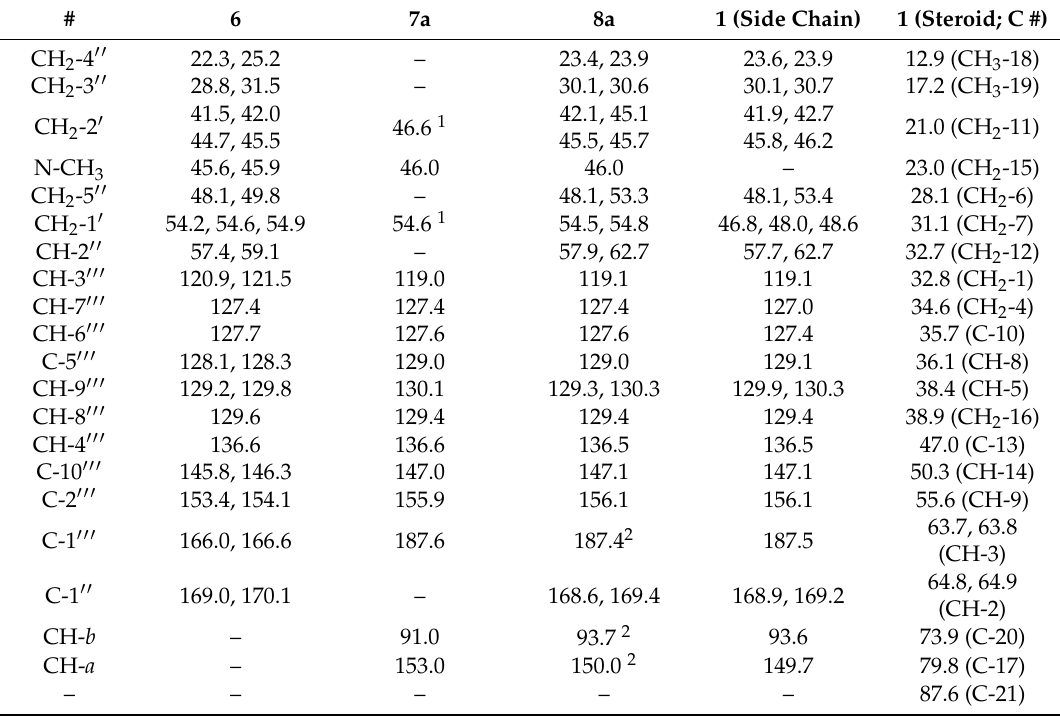
Table 1. Chemical shifts ( δ in ppm) and assignation of carbons from compounds 6 , 7a , 8a, and 1